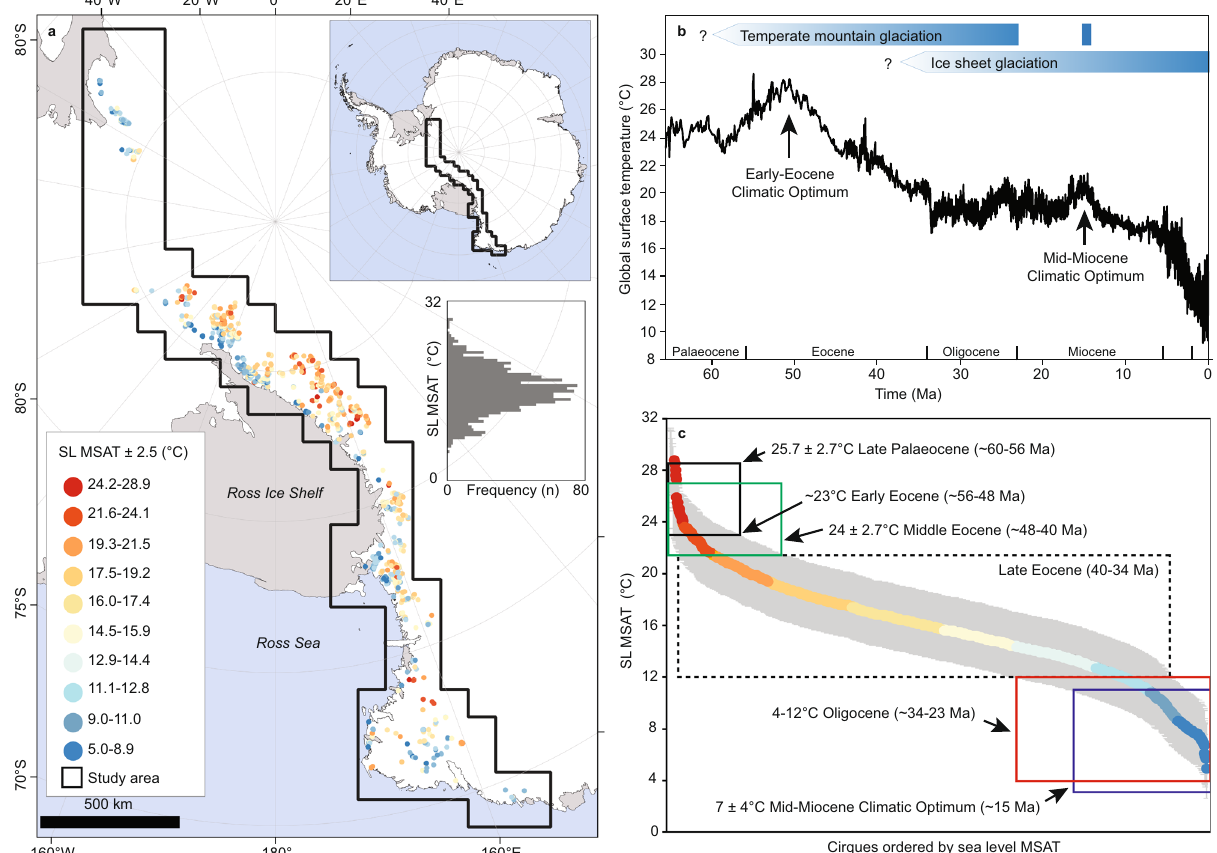
Fig. 1 | Palaeotemperature reconstructions from Antarctica and globally. a Glacier-free cirques ( n = 1292) in the Transantarctic Mountains coloured according to the sea level mean summer air temperature (SL MSAT) required for them to be occupied by temperate (warm-based) mountain glaciers. The inset histogram shows the frequency distribution of SL MSAT. Antarctic coastline data from the SCAR Antarctic Digital Database, accessed [2021] 49 license: https://creativecommons.org/licenses/by/4.0/. b Global